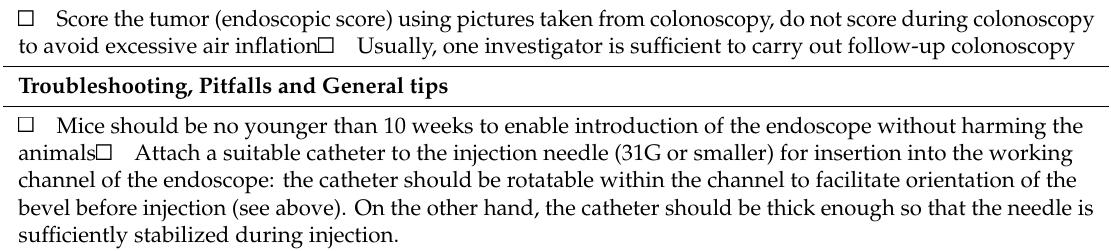
Table 3. Checklist of steps and tips for successful establishment of the current endoscopy-guided mouse model of colorectal cancer.